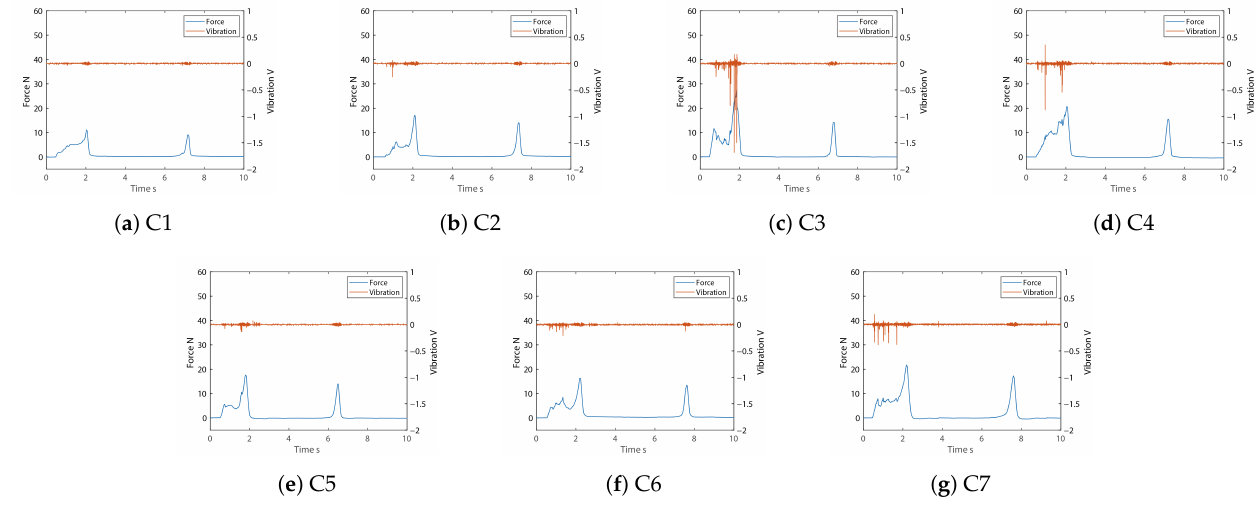
Figure 9. Typical force and vibration data of seven nugget